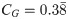
Varying effects of adding a link to a network on the clustering coefficient.(a) Original network with clustering coefficient CG=0.38¯. (b) Network after connecting two nodes with no common neighbours, CG+e1=0.27¯. (c) Network after connecting two nodes with a common neighbour, CG+e2=0.7¯.